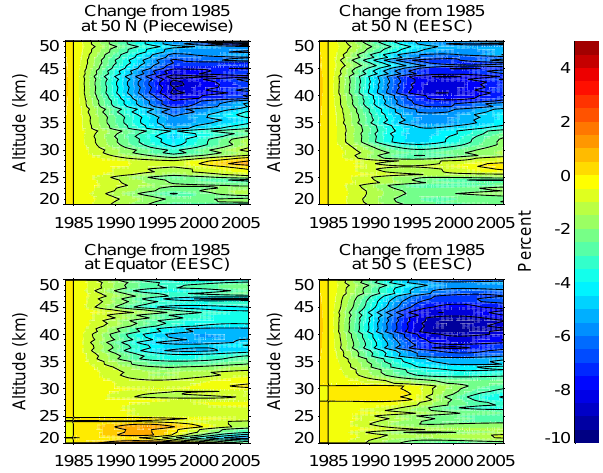
Figure 16. Some examples of the long-term trend term computed using the STS regression. The term in the top left comes from the use of a piecewise linear term, while the other three come from the use of two orthogonal EESC terms. Contour intervals are